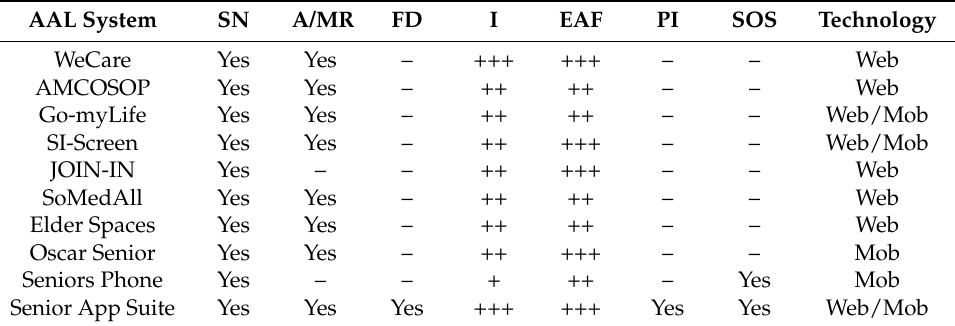
Table 3. Comparing Senior App Suite Features with other AAL